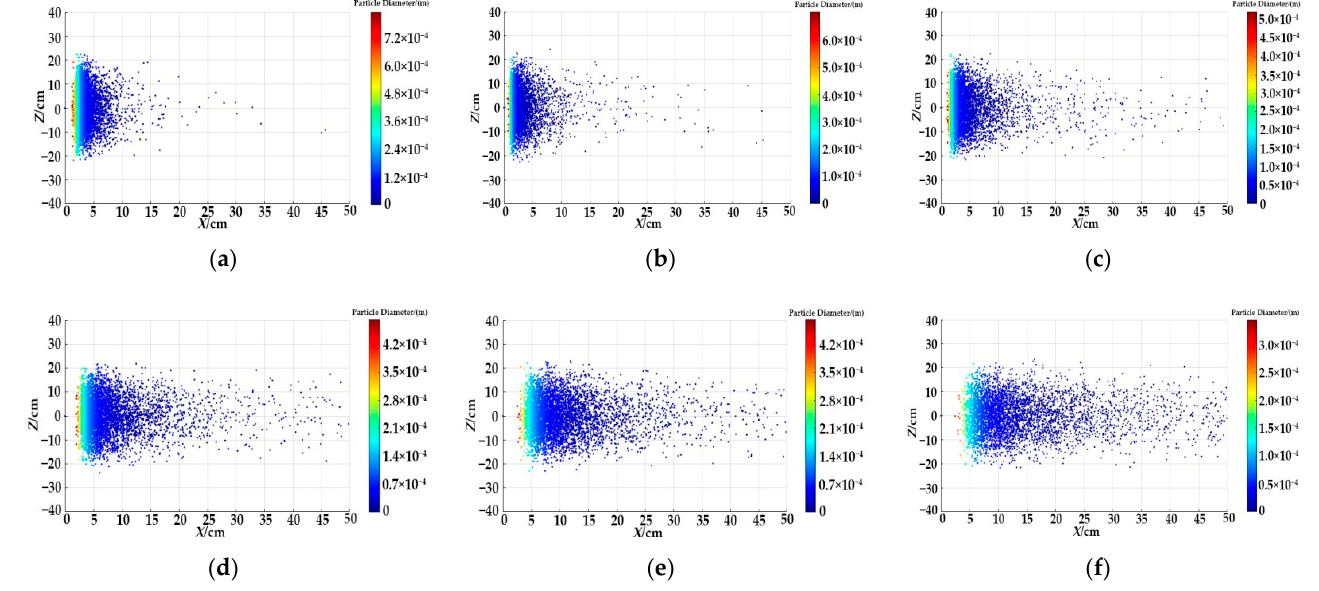
Figure 6. Droplet distributions on the reference surface with different spray pressure: 0.3 MPa ( a ); 0.4 MPa ( b ); 0.5 MPa ( c ); 0.6 MPa ( d ); 0.7 MPa ( e ); 0.8 MPa ( f ).